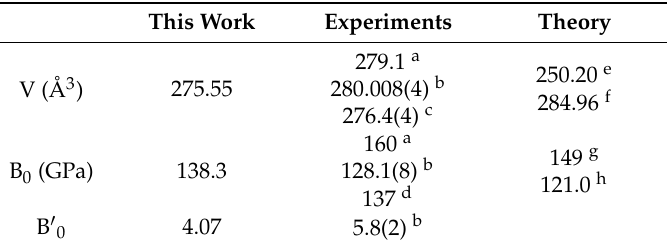
Table 3. Volume at 0 GPa, bulk modulus, B 0 , and its pressure derivative, B (cid:48) 0 , from a fit with a 3th order Birch Murnaghan EOS. This Work Experiments Theory